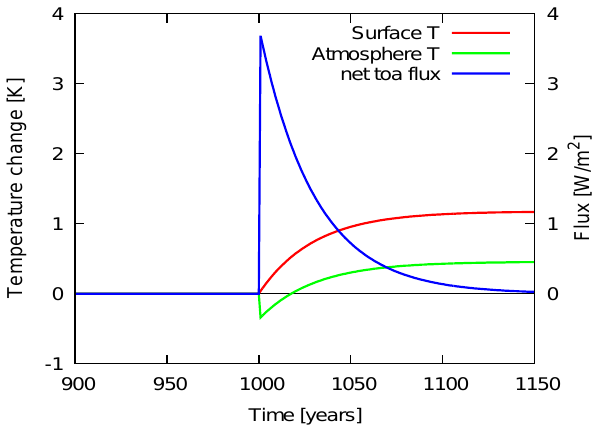
Fig. 7. Temporal development of the top of the atmosphere flux ( toa F net ) in Wm − 2 , surface and atmosphere temperature ( T s and T a ) in an experiment, where after a 1000yr spin-up CO 2 concentra- tion is doubled.